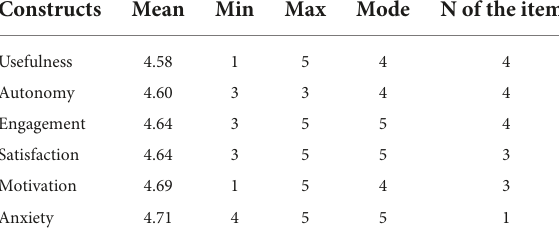
TABLE 3 Descriptive statistics of the perception of flipped classroom